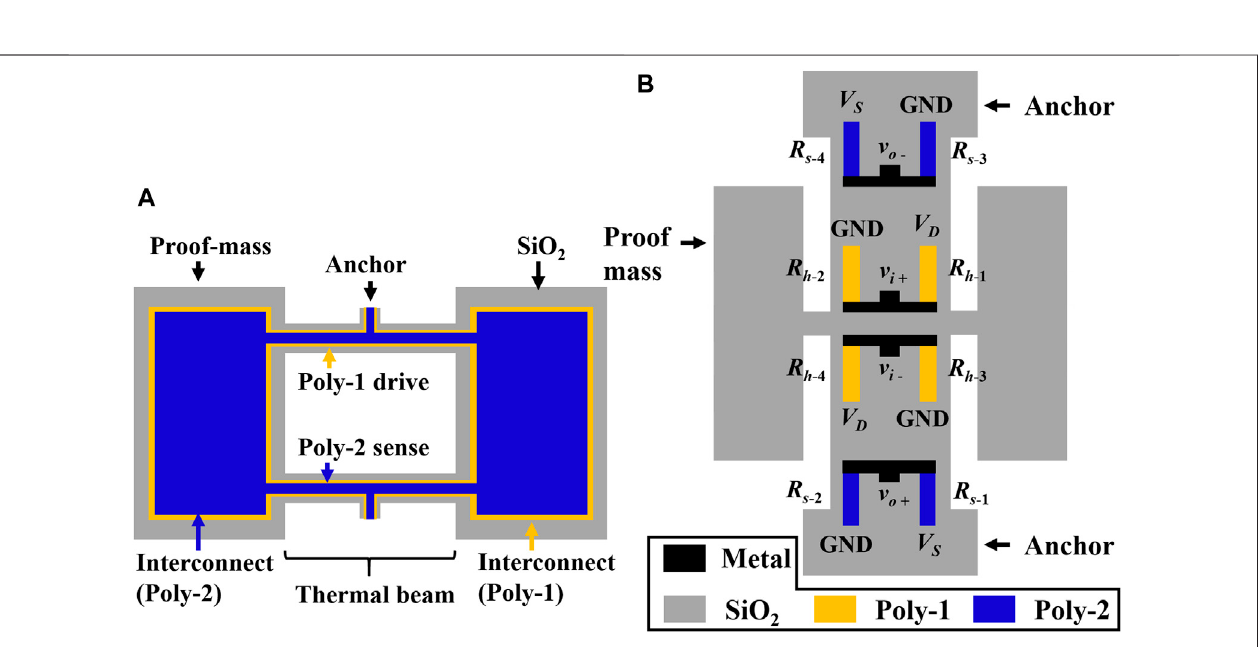
Frontiers in Mechanical Engineering |